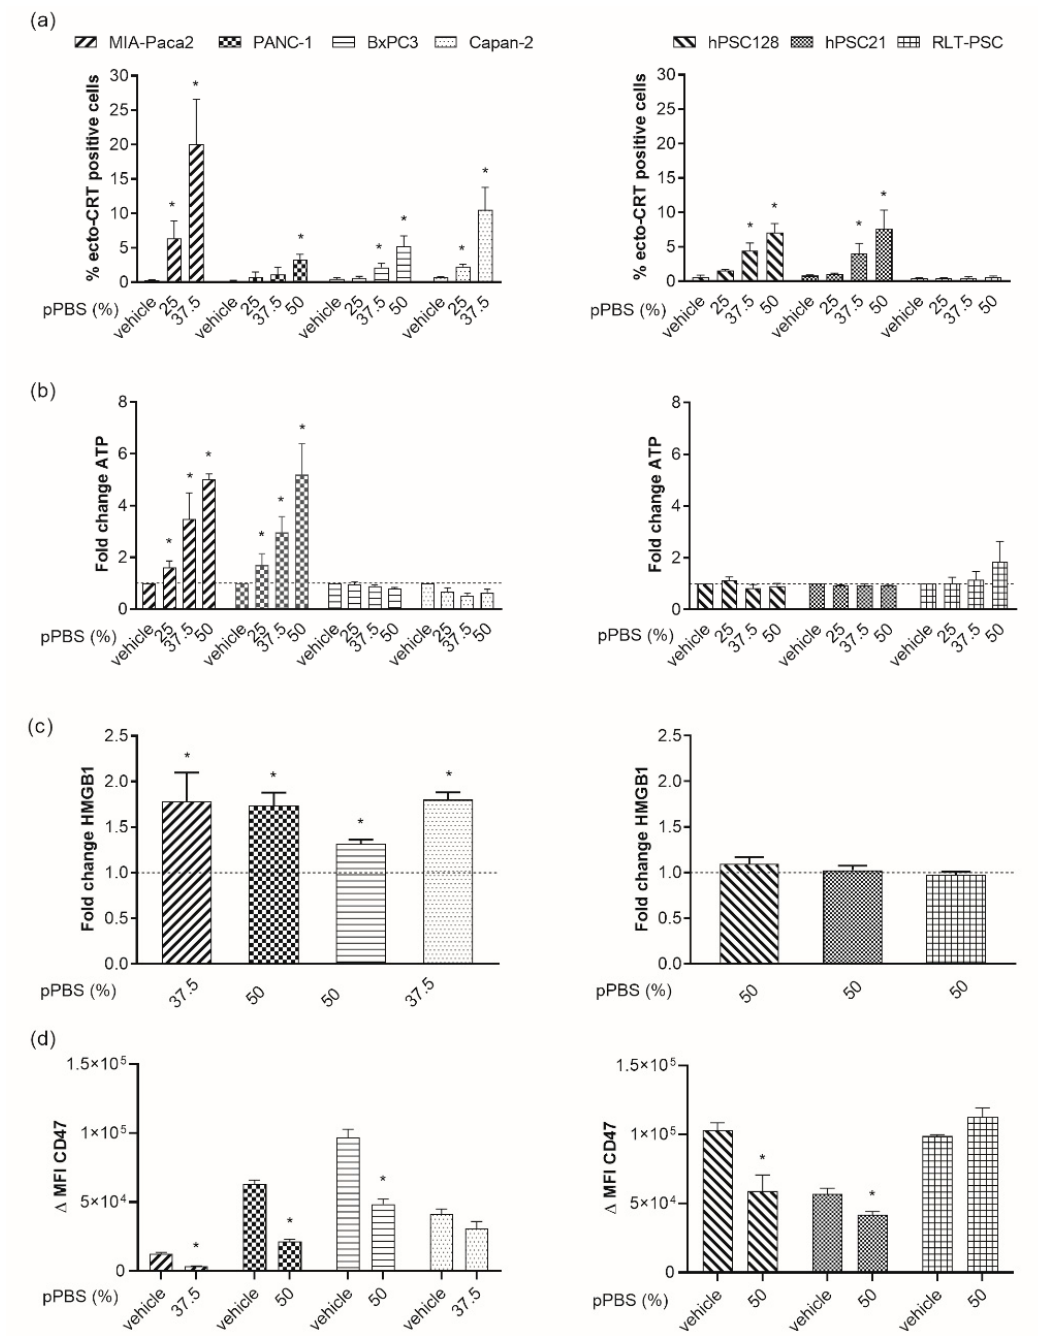
Figure 2. Release of immunogenic cell death (ICD) markers after pPBS treatment. ( a ) Percentage of surface-exposed calreticulin (ecto-CRT) positive cells after increasing the dose of pPBS treatment (25%, 37.5%, 50% pPBS). ( b ) Adenosine triphosphate (ATP) secretion 4 h post treatment in the supernatant. ( c ) High-mobility group box 1 (HMGB1) secretion 48 h post pPBS treatment in supernatant. These data demonstrate the fold change of ATP secretion (ng/mL range) against the untreated control. ( d ) Difference in mean fluorescence intensity ( Δ MFI) of CD47 after 48 h of pPBS treatment. Δ MFI represents [(MFI staining treated – MFI isotype treated) – (MFI staining untreated – MFI isotype untreated)]. Different concentrations of pPBS treatment are used (25%, 37.5%, 50% pPBS). In the left graphs, four different PCC lines are represented (MIA-Paca-2, PANC-1, BxPC3, Capan-2), and in the right graphs, three different PSC lines are represented (hPSC128, hPSC21, RLT-PSC). Graphs represent mean ± SEM of ≥ 3 independent experiments. * p < 0.05 significant difference compared with untreated conditions.